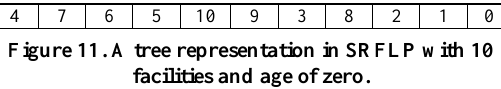
Figure 11. A tree representation in SRFLP with 10 facilities and age of